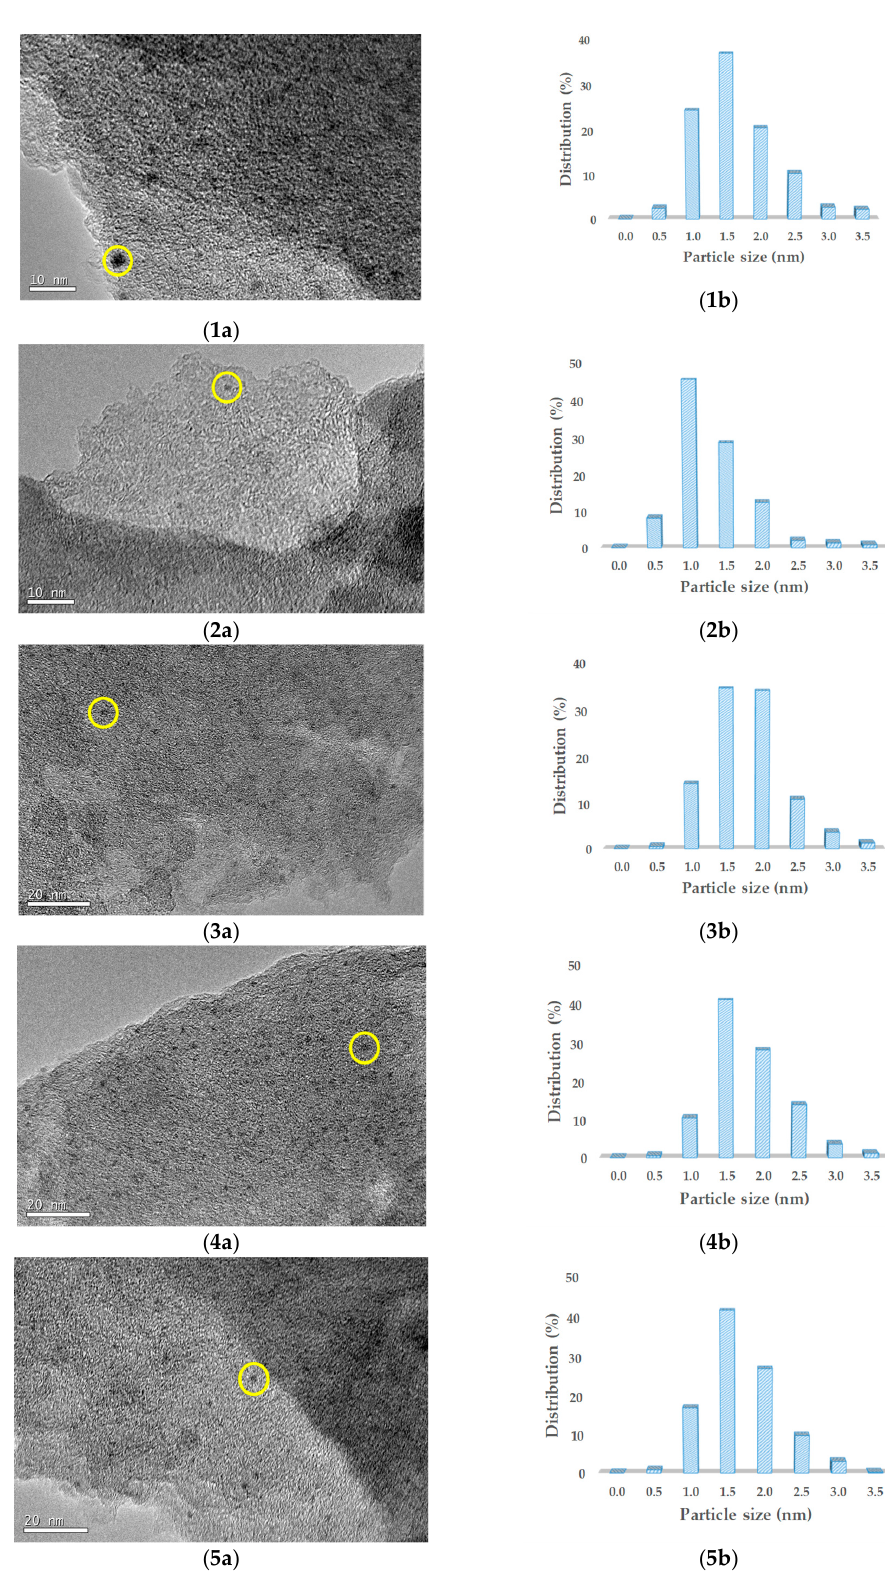
Figure 3. TEM images ( a ) and palladium particle size distribution ( b ) of the fresh-reduced ( 1 ), 5 h used ( 2 ), 40 h used ( 3 ), 80 h used ( 4 ), and 120 h used ( 5 ) Pd / C